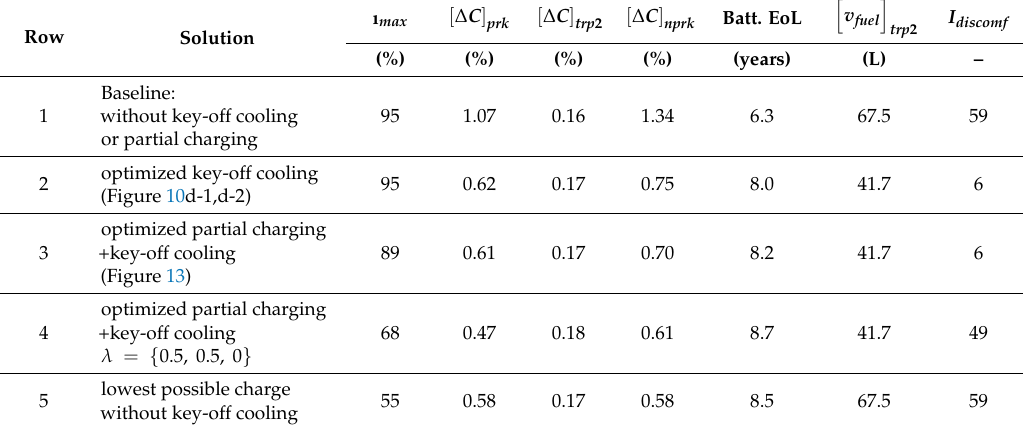
Table 8. Breakdown of cost terms for the solution of Problems (13) and (16). Due to imposing a minimum charge of 40%, the impact of charge optimization on the vehicle in Trip 1 is negligible, and the associated cost terms are not quoted in the